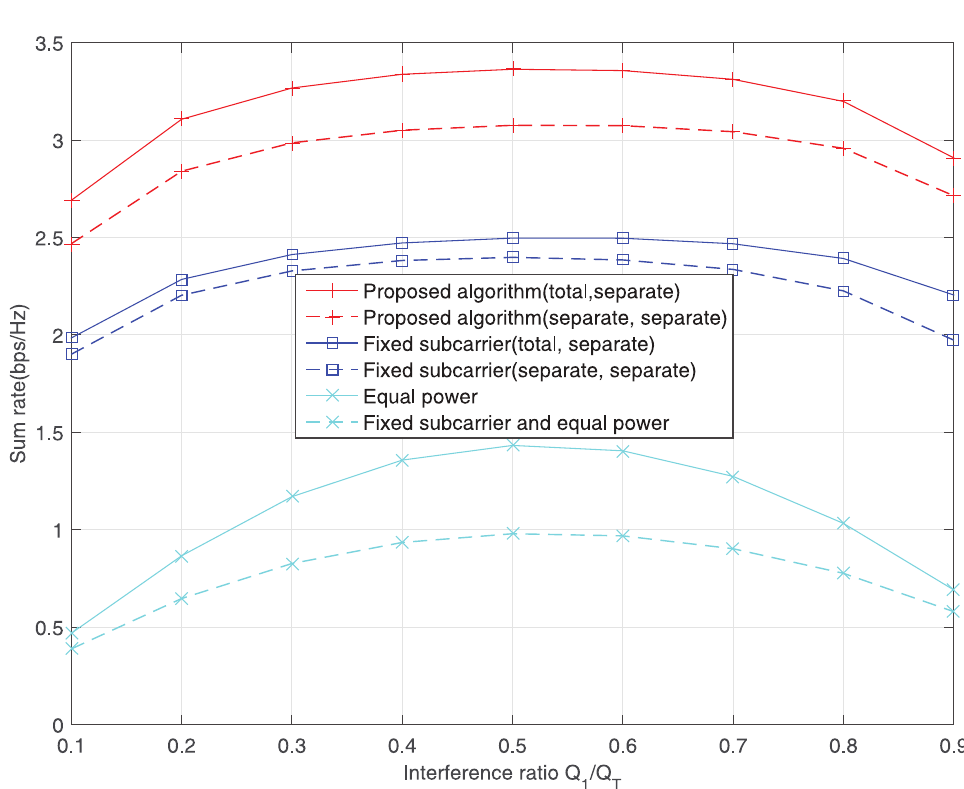
Fig 6. Effect of interference ratio on the sum rate, where Q T = 10dB and average SNR = 10dB.